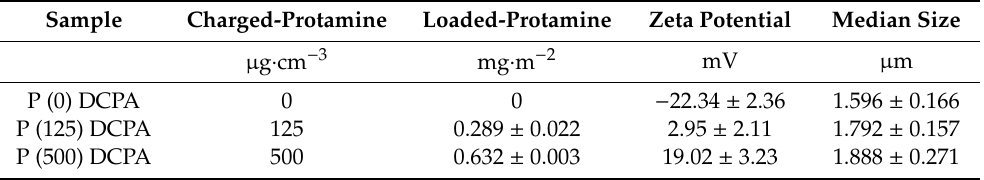
Table 1. Characterization of protamine-loaded dicalcium phosphate anhydride (DCPA) powders.